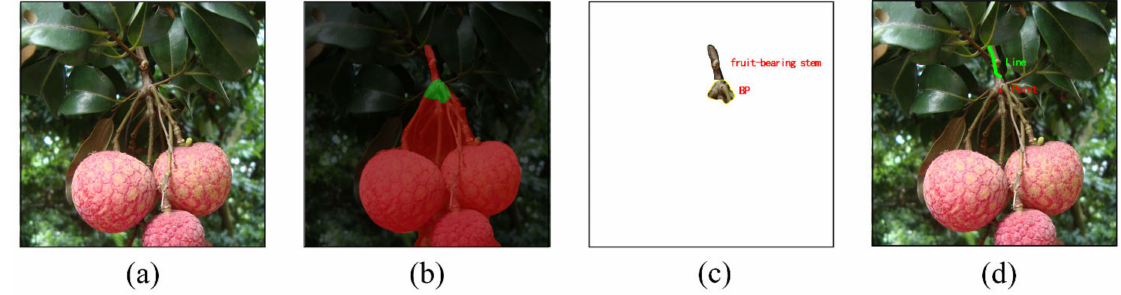
Figure 17. Key steps of the process: ( a ) original image; ( b ) centermost string; ( c ) bifurcation branch and fruit-bearing branch mask; ( d ) final